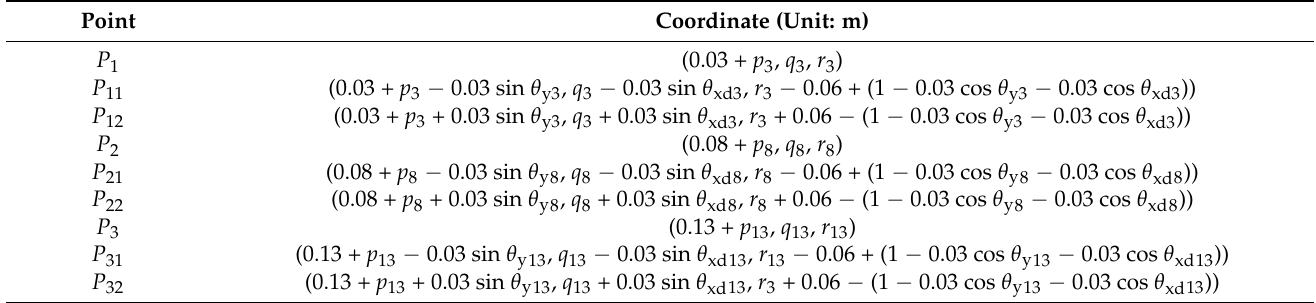
Table 5. Coordinates of points after deformation.